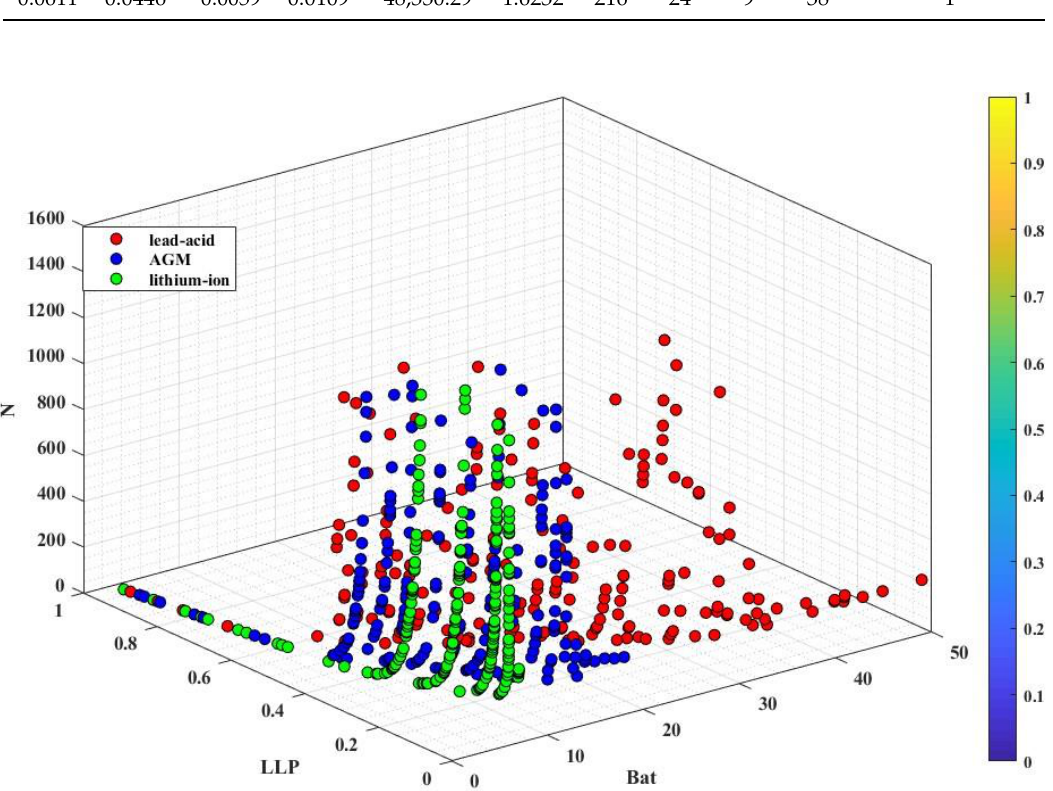
Figure 11. Scattering of N and Bat at predefined levels of LLP using the PESA-II method for three types of batteries. Table 7. Minimum and maximum values of three objectives were found on the basis of the PESA-II method.